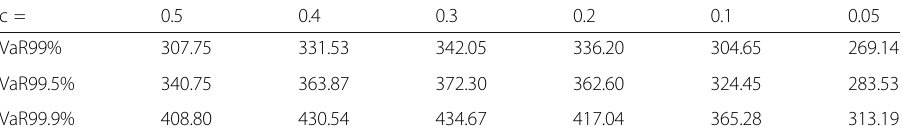
Table 4 Value-at-Risk for a portfolio of two assets (correlation ρ = 0.5) c =